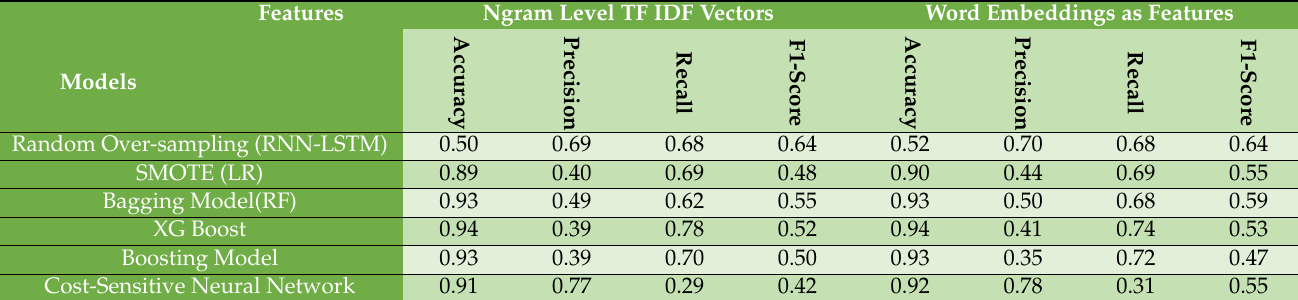
Table 5. Model performance for data and algorithmic